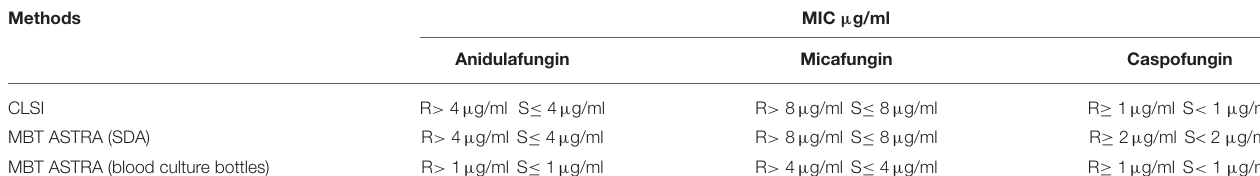
TABLE 3 | Comparison of suggested breakpoints against echinocandin class drugs for C. auris tested by CLSI microdilution and MBT ASTRA. Methods